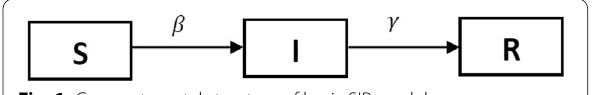
Fig. 1 Compartmental structure of basic SIR model